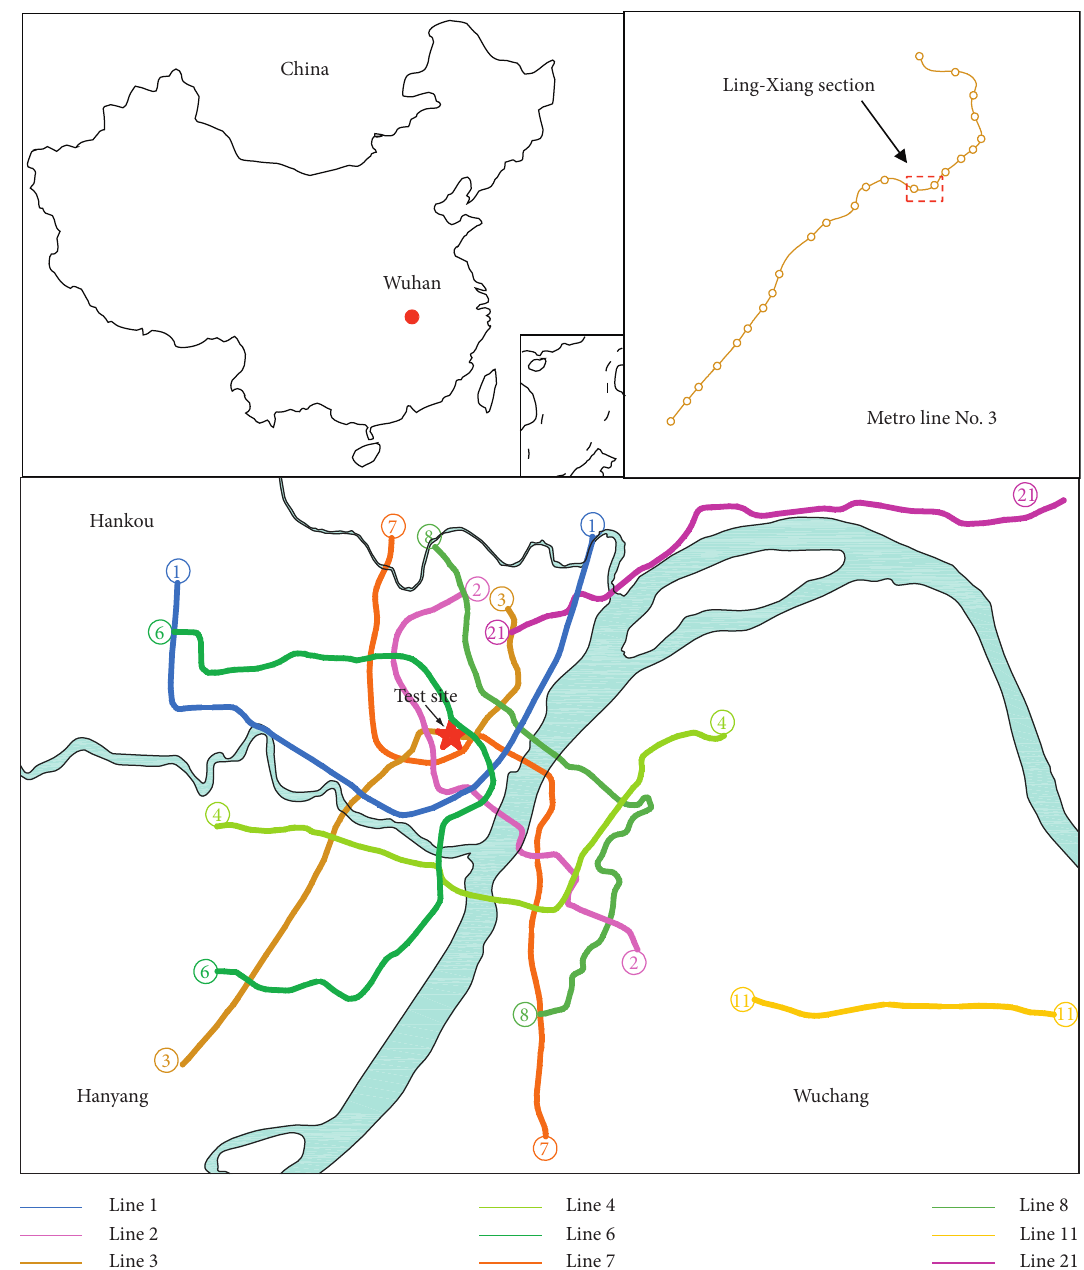
Figure 7: Metro lines of Wuhan city and the location of field test